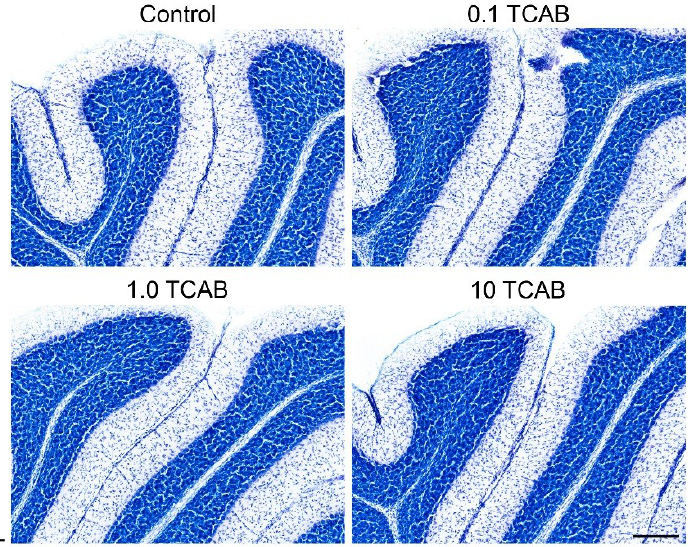
Figure 12. Nissl Staining of Cerebellum at PND21. Representative Nissl staining of the 5–6th cerebellar lobe showing normal distribution of cerebellar granule cells and Purkinje cells at PND21. All animals showed normal development of cerebellar cellular organization and the migration of extracellular granule cells to the intracellular granule cell layer with no evidence of cells remaining in the extracellular granule layer at the primary fissure between folia of lobes. Scale bar = 100